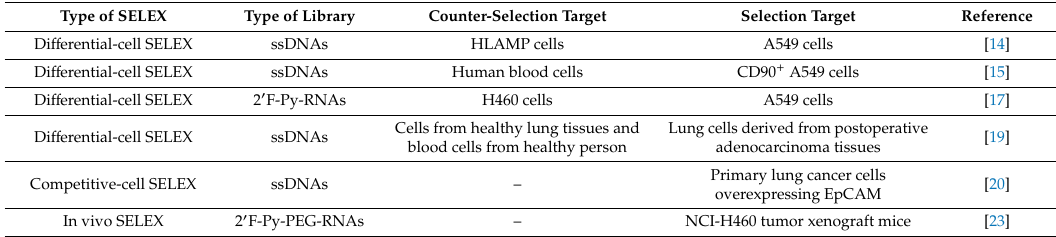
Table 1. Summary of SELEX procedures applied to small-cell lung cancer